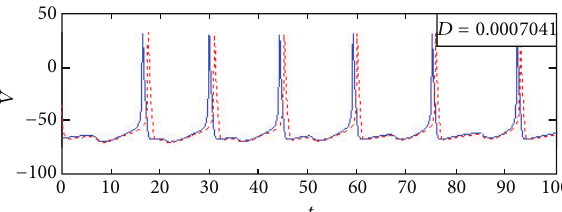
Figure 14: (a) Two coupled MCs, (b) ring-like neuronal network of GCs, and (c) grid-like neuronal network of GCs.